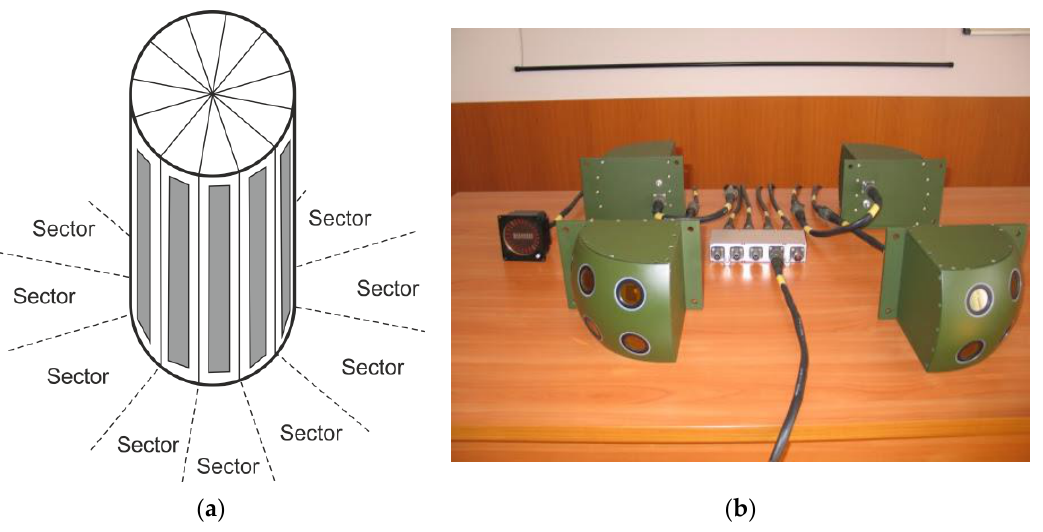
Figure 1. ( a ) Idea of a low-angular-resolution, multi-sector laser warning receiver (LWR) scheme. ( b ) Photo of laser warning system (LWS) “Procjon,” developed in our institute in the past (source: http://www.ioe.wat.edu.pl).